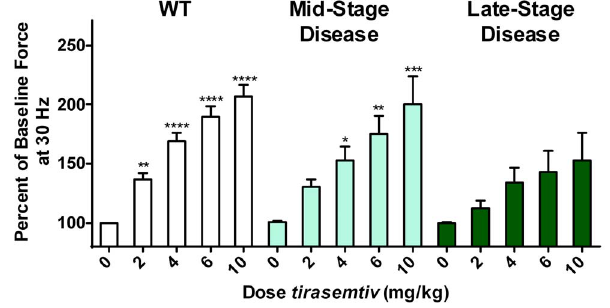
Figure 6. Infusion of tirasemtiv increases in situ EDL muscle force in wild-type and B6SJL-SOD1 G93A transgenic mice at mid- stage (90–100 days) and late stage (110–115 days) disease. The EDL muscle was stimulated every 2 minutes with a 5 Hz stimulus (1 ms pulse width, 350 ms train duration) via the peroneal nerve. Tirasemtiv was then administered as a 2 minute i.v. bolus in four cumulative doses up to a total of 10 mg/kg. (WT mice, n=8; mid-stage B6SJL-SOD1 G93A mice, n=5; late-stage B6SJL-SOD1 G93A mice, n=6 Data are expressed as mean tension 6 SEM. *p , 0.05, **p , 0.01, ****p , 0.0001 vs. respective baseline